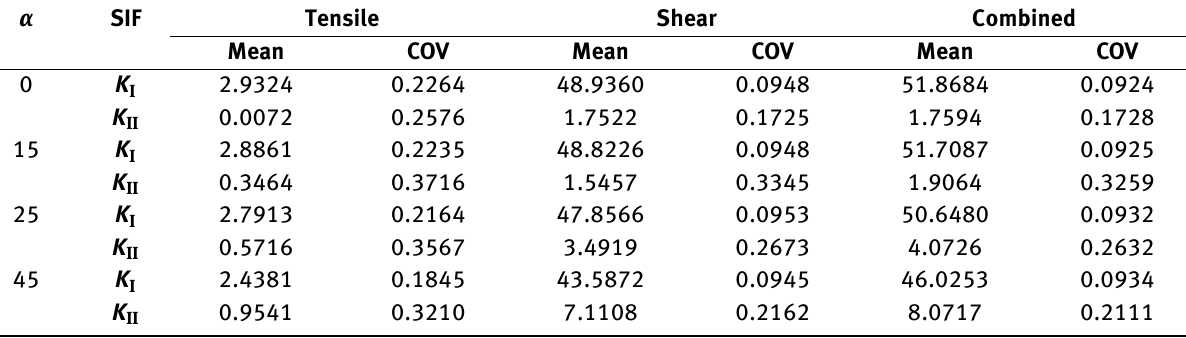
Table 6: Effect of crack angle on the normalized mean and COV of K I and K I I of double edge cracked FGMs plate subjected to uniaxial tensile, shear and combined stresses α SIF